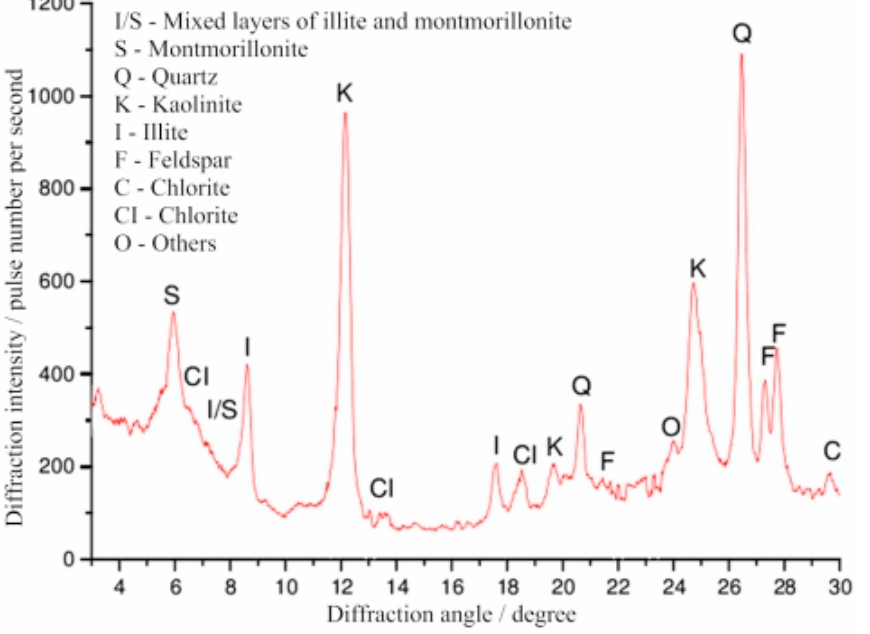
Figure 8. Mudstone mineral composition X-diffraction pattern.